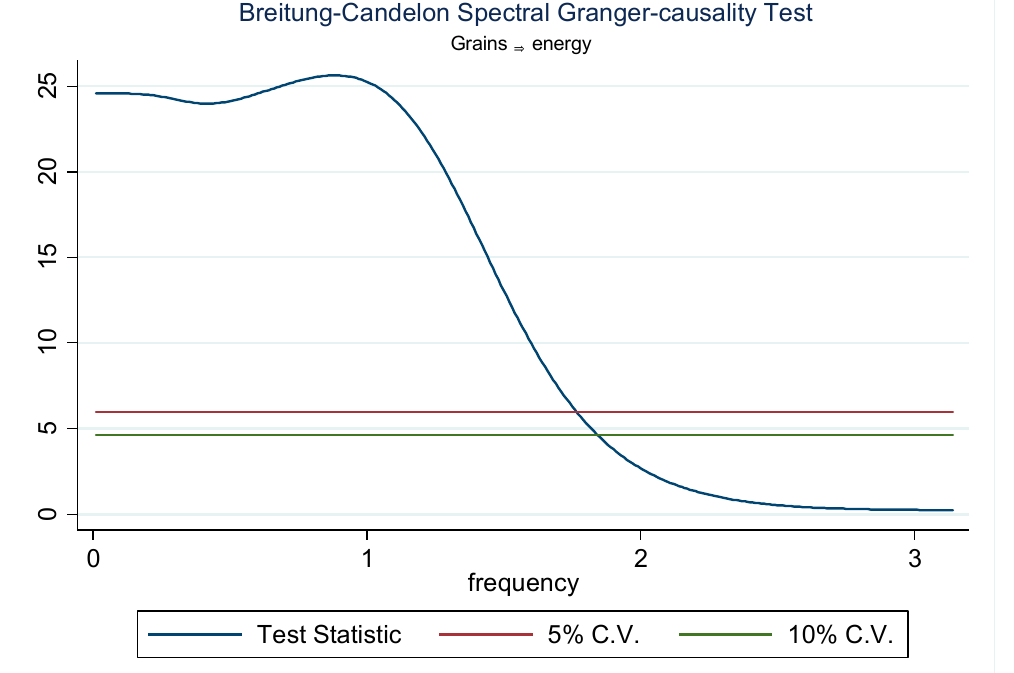
Figure 5. Spectral BC causality from grains to energy.